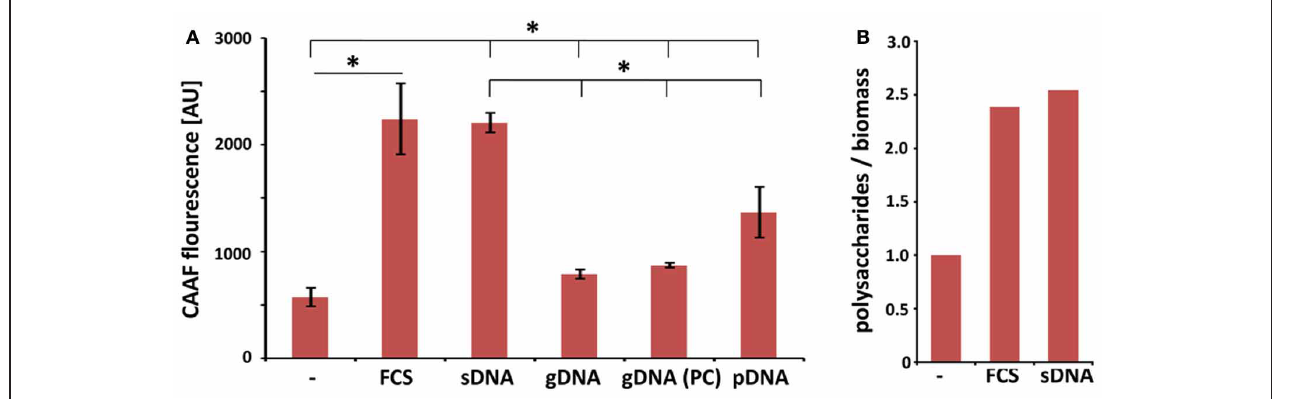
FIGURE 4 | Extrinsic DNA increases ECM formation in biofilms. (A) CAAF fluorescence of total fungal polysaccharides was determined in biofilms seeded at an initial density of 10 4 per well and used as a measure for ECM production in biofilms in the presence of 1mg ml − 1 DNA from indicated sources (sDNA, sheared herring sperm DNA; gDNA, genomic DNA from A. fumigatus ; PC, phenol chloroform